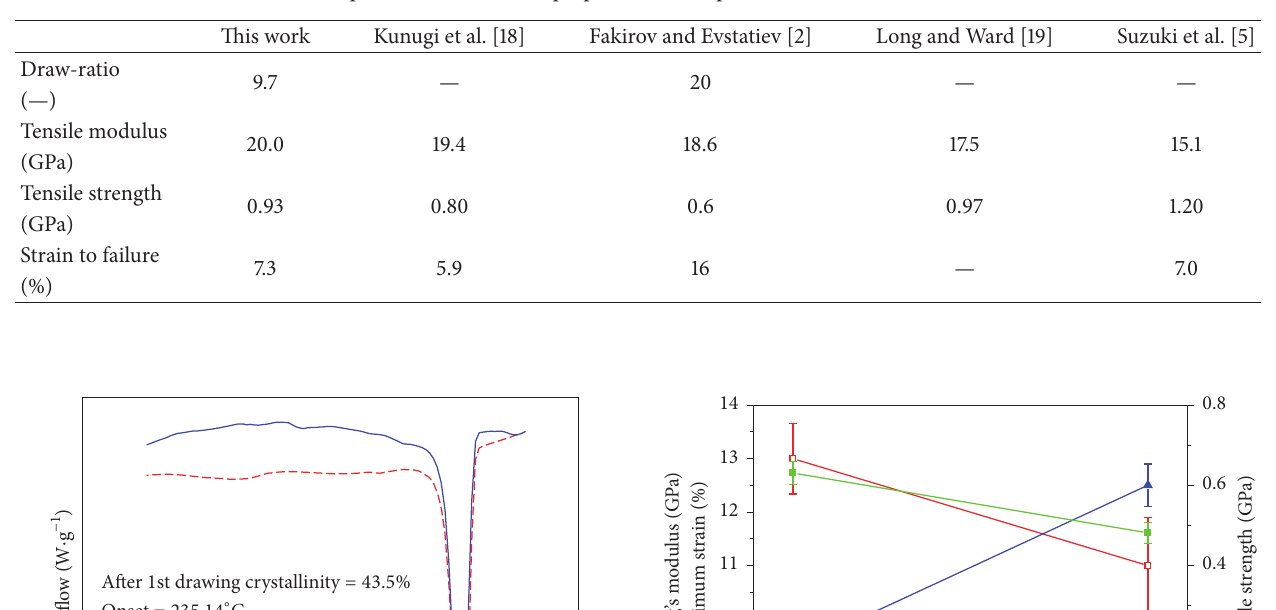
Table 5: A comparison of mechanical properties of PET produced in this work and in literature.